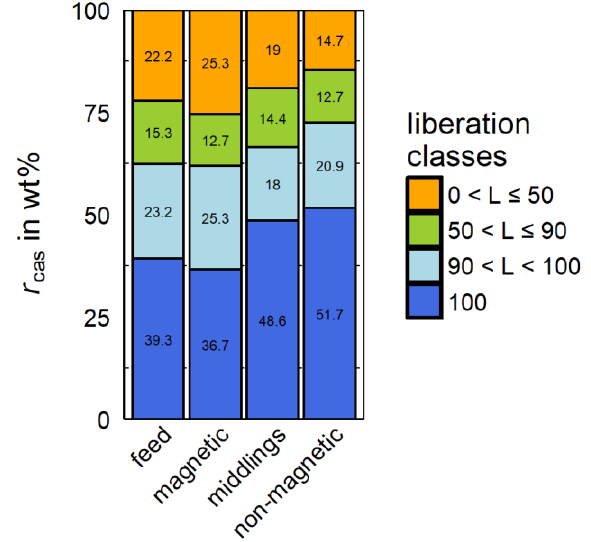
Figure 11. Distribution of cassiterite ( r cas ) in the different liberation classes for the three products.